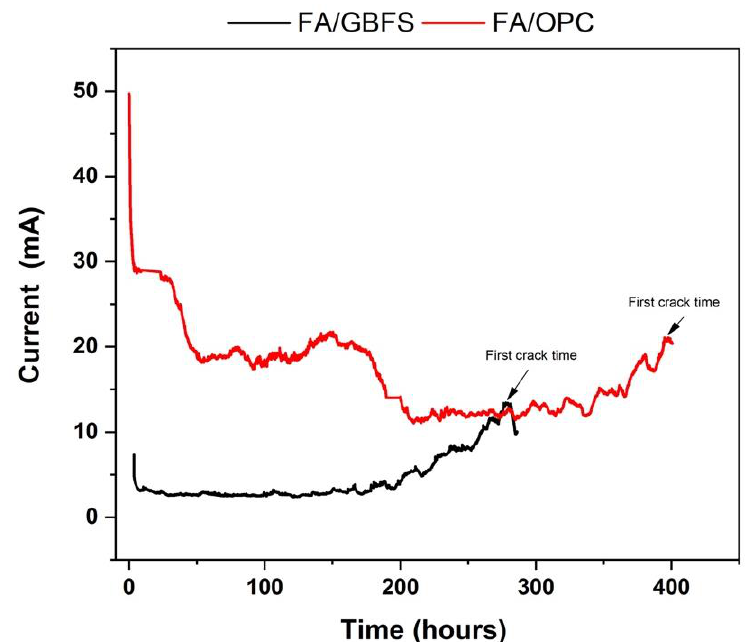
Figure 6. Current intensity curve versus the test time on reinforced concrete (FA/GBFS and FA/OPC).